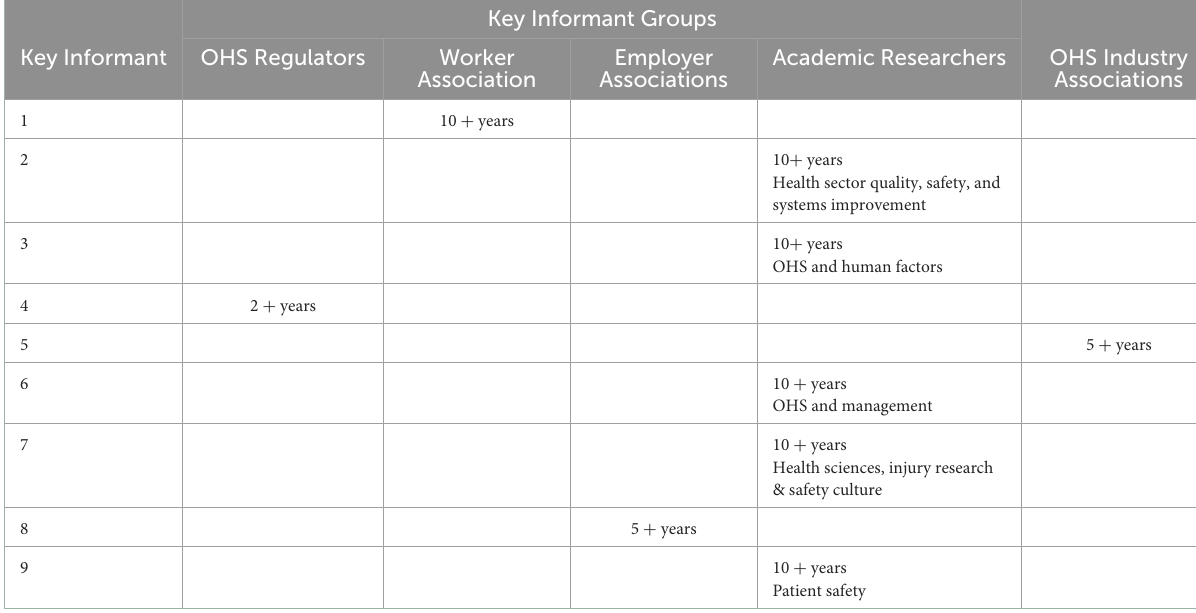
TABLE 2 Summary of key informant stakeholder groups and